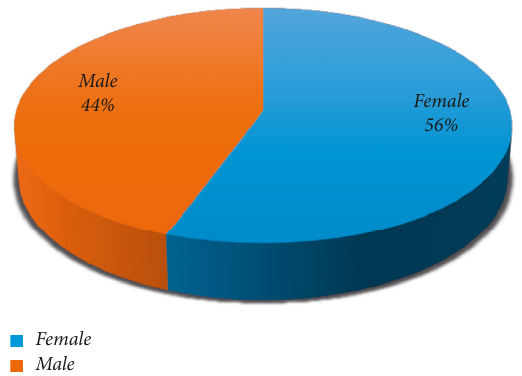
Figure 1: Distribution of cutaneous melanoma according to